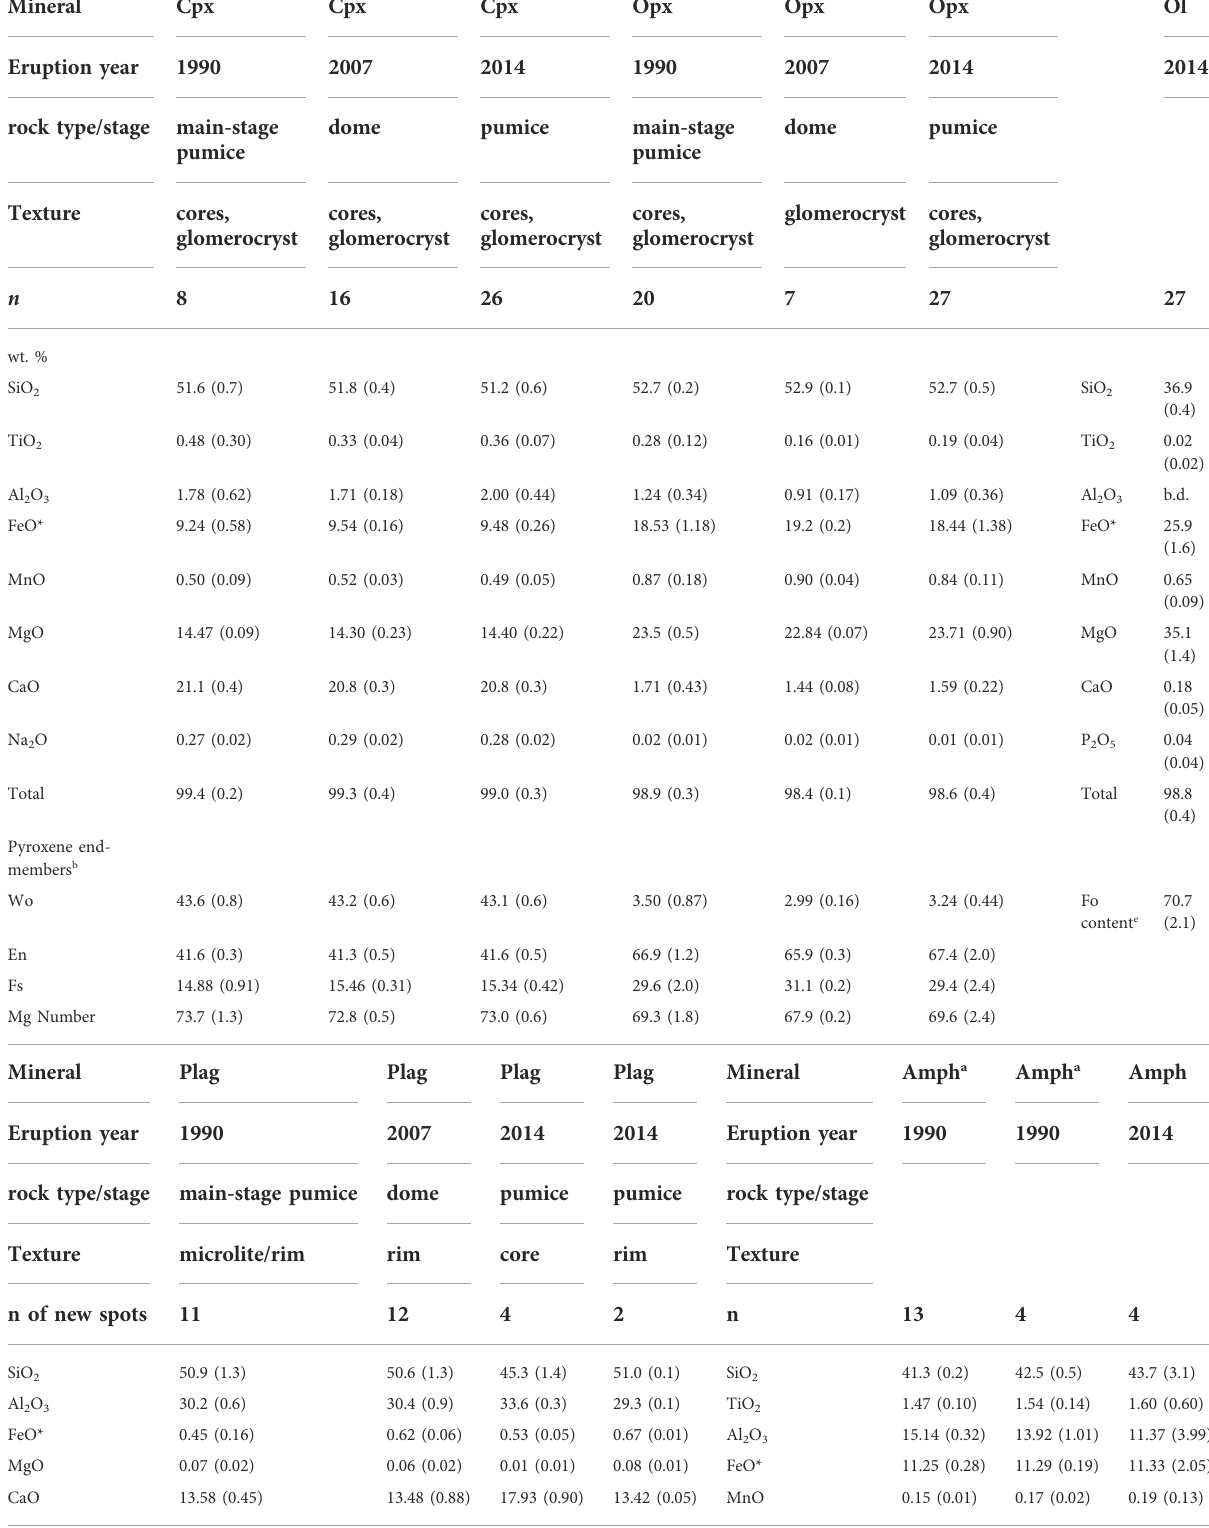
TABLE 3 Summary of representative mineral compositions from the 1990 – 2014